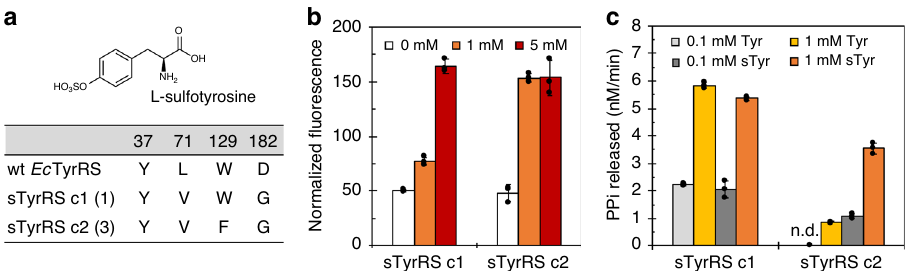
Fig. 1 Characterization of sTyrRS candidates. a Mutations in the evolved sTyrRS variants. Numbers in parentheses represent the occurrence of the variant from the selection. b Fluorescence readings of yeast cells expressing the evolved sTyrRSs and an yeGFP mutant that contained an amber mutation at position N149. sTyr was included in culture media at 0 mM (open bar), 1 mM ( fi lled orange bar), or 5 mM ( fi lled red bar). Fluorescence intensity was normalized to cell growth. c Initial velocities of pyrophosphate release by sTyrRS variants in the presence of Tyr and sTyr. Tyr was included in assays at 0.1 mM ( fi lled gray bar) or 1 mM ( fi lled yellow bar). sTyr was included in assays at 0.1 mM ( fi lled dark gray bar) or 1 mM ( fi lled orange bar). Assays were carried out in the presence of 10 μ M recombinant Ec tRNA CUA . n.d., not detected. b , c Data are plotted as the mean ± standard deviation (s.d.) from n = 3 independent experiments. b , c Source data are provided as a Source data